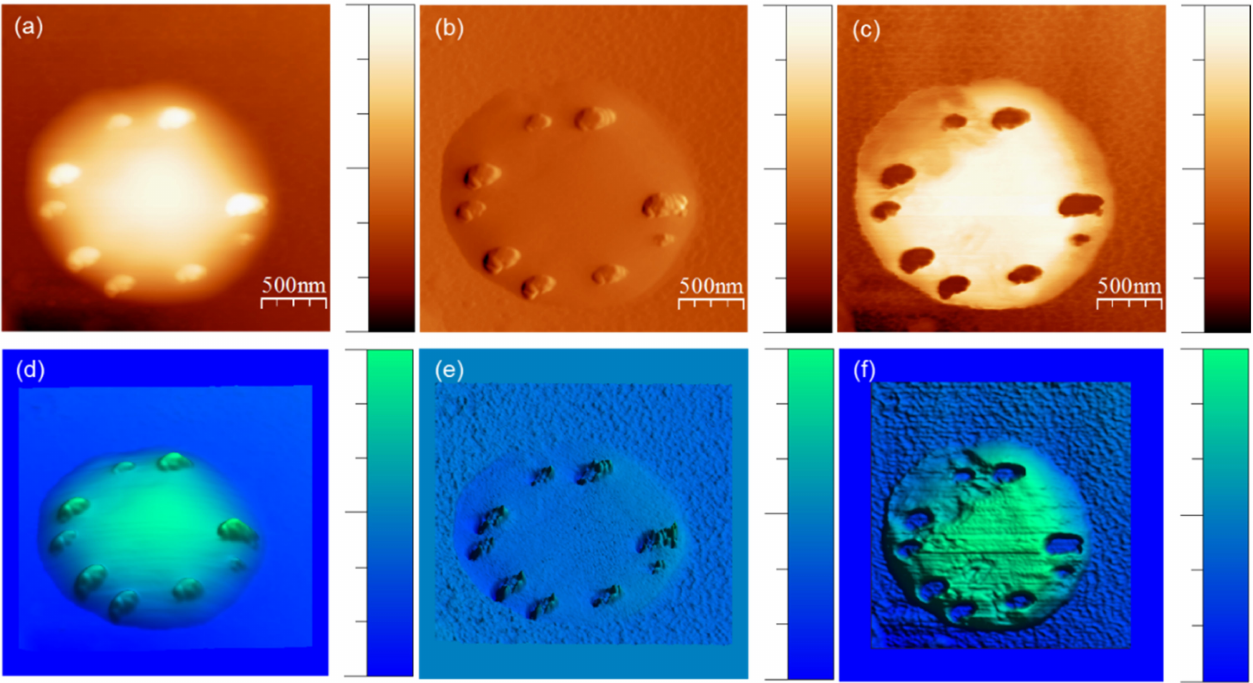
Figure 6. QNM-AFM images showing colchicine bound to cell on SiO 2 substrate. Top panel, ( a ) height image, the height of the cell is represented in color scale 0 (dark fields)–175 nm (light fields). ( b ) Force error image, the force of the cell is represented in color scale 0 (dark fields)–326 nN (light fields). ( c ) Adhesion image of the cell, the adhesion of the cell is represented in color scale 0 (dark fields) –206 nN (light fields). The corresponding 3D images are presented in bottom panel, ( d – f ),